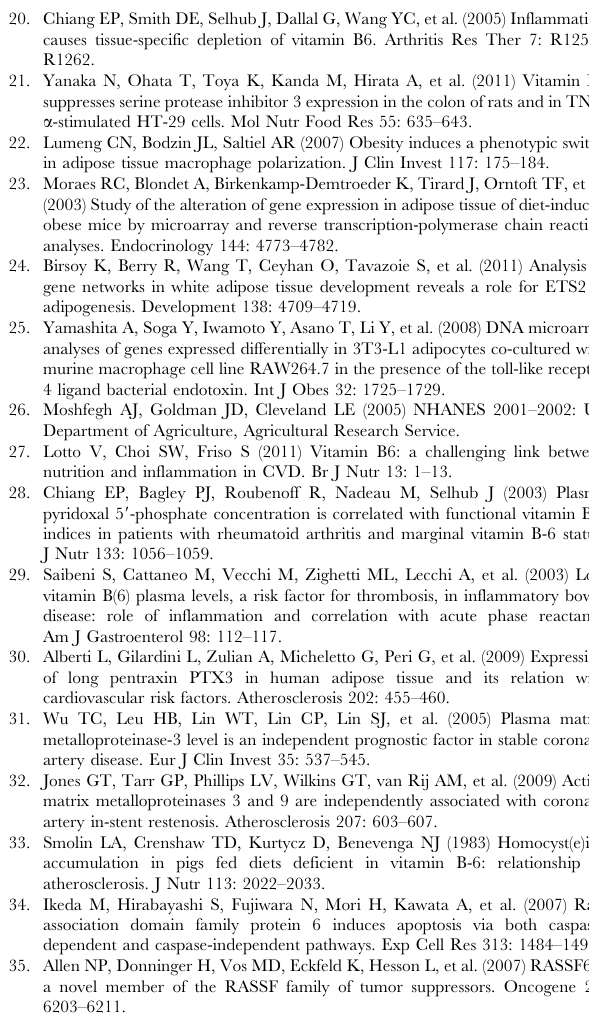
Figure S3 Effect of vitamin B6 supplementation on glucose tolerance in mice. At the end of feeding period, mice